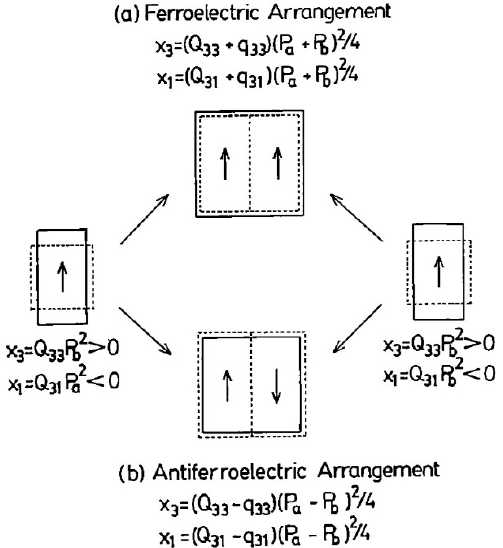
Figure 17. Spontaneous strain changes associated with sublattice interactions in the electrostrictive effect. Illustration is drawn in the case of q 33 and q 33 > 0.